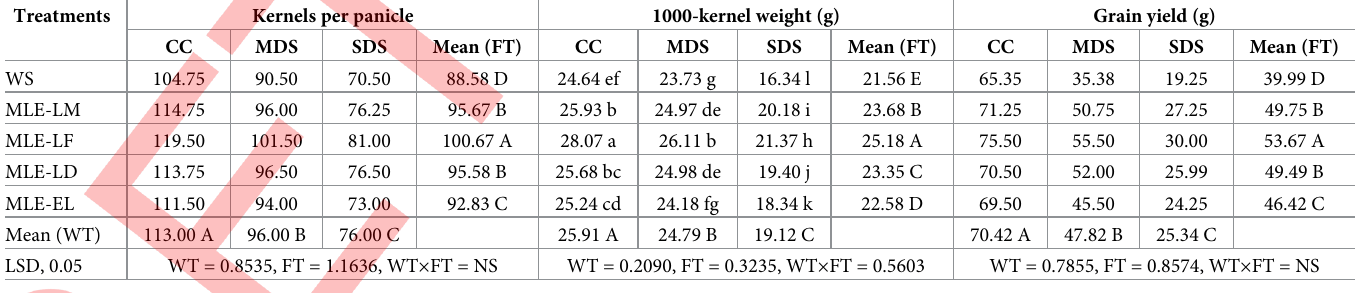
Table 3. Impact of leaf extracts from local and exotic moringa landraces on number of kernels per panicle, 1000-kernal weight and grain yield of rice cultivated under different levels of drought stress (n = 4). Treatments Kernels per panicle 1000-kernel weight (g) CC